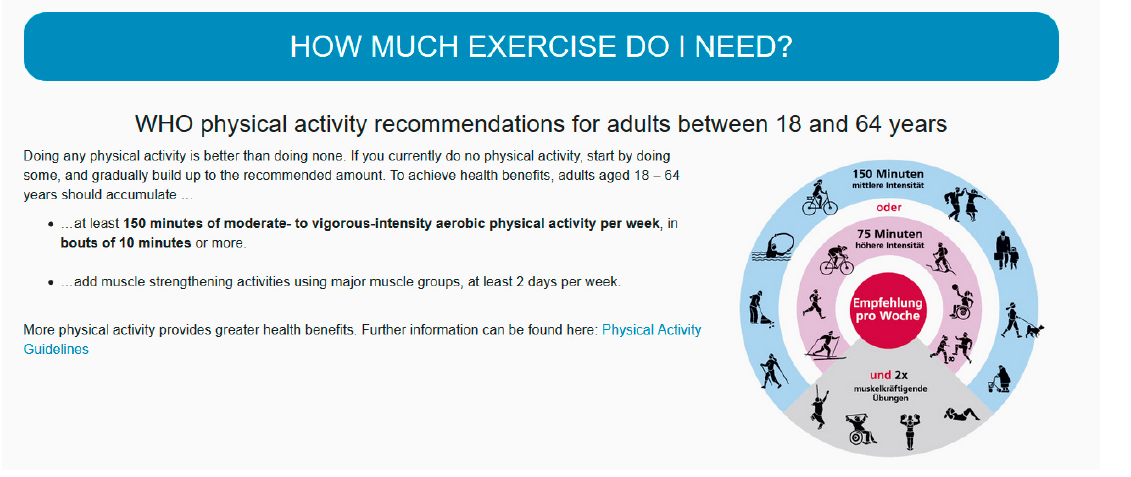
Figure 3. List of health ‐ enhancing effects of physical activity. Visualization by TraffiCon GmbH, Salzburg. 4.3.3. Personalized Features—Home Section The last navigation link, which includes the theoretical background, is named “Home”. To enter this area, the user needs a user name and a password. Users can define their favorite routes and collect personal data, such as their performed amount of physical activity while using public transport within a certain time period. Future development of this feedback could include further features such as sharing functions to allow individuals to compete with each other or a function for the collection of bonus points, which could be transferred into incentives (e.g., vouchers). The focus ‐ group participants suggested a lot of ideas for further functions. The SDT’s concept of self ‐ efficacy was addressed by adding personalized features, which guide the user toward the goal of reaching at least the recommended amount of 10,000 steps per day. A concept from the HBM which was integrated was extrinsic motivation. The stages of action and maintenance from the TTM were addressed by providing the described personalized functions so that the users have feedback about their activities.